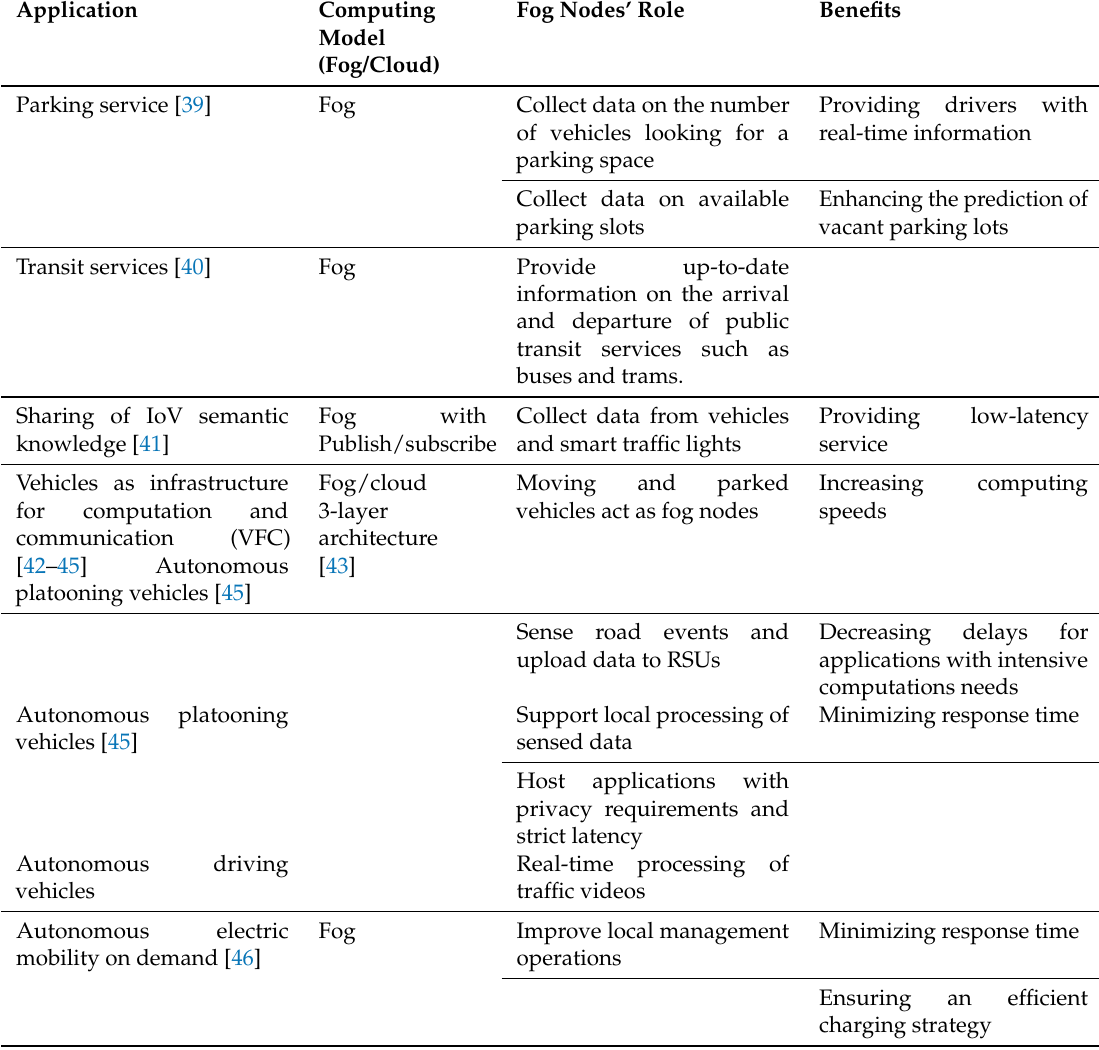
Table 1. Fog computing based transportation